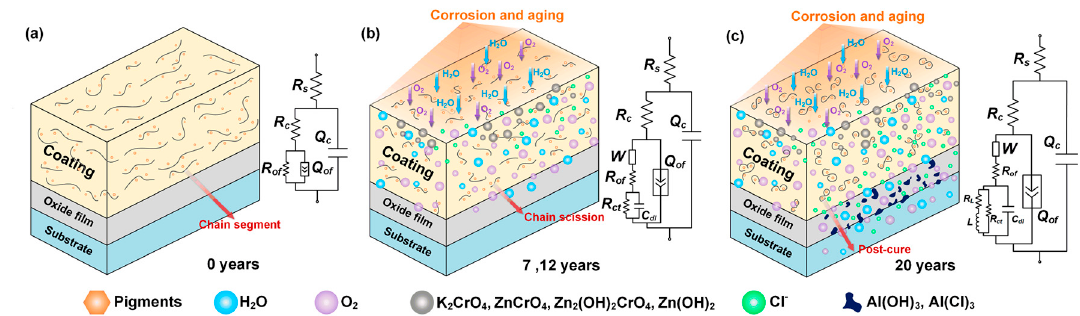
Figure 16. The mechanisms of corrosion and aging of epoxy primer-coated specimens after exposure for different numbers of years: ( a ) 0 years, ( b ) 7, 12 years, ( c ) 20 years, and the equivalent circuit of the EIS data from Figure 14.